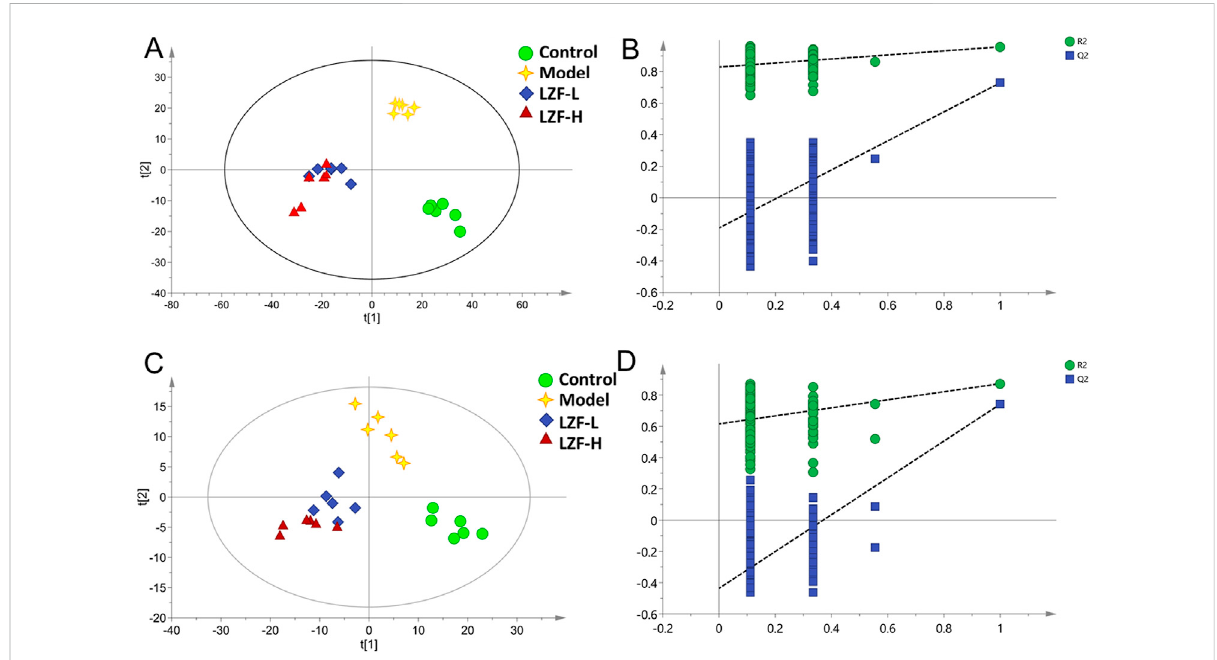
FIGURE 2 Multivariate statistical analysis of serum mass spectrometry. (A) PLS-DA score plot in the positive ion mode; (B) 200 permutation tests of the PLS-DA score plotin thepositive ion mode; (C) PLS-DA score plot inthenegativeion mode; and (D) 200permutationtests of thePLS-DA score plot in the negative ion mode.